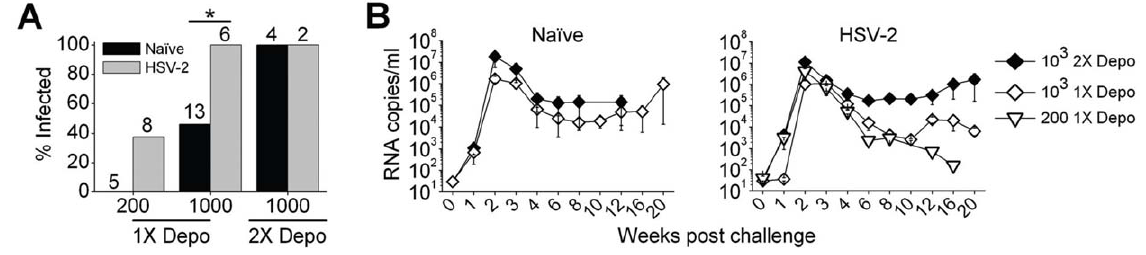
Figure 2. HSV-2-exposed macaques are more susceptible to vaginal SHIV-RT infection. (A) Naı¨ve or HSV-2-exposed macaques were challenged with the indicated TCID 50 of SHIV-RT or SHIV-RT and HSV-2 (respectively), after receiving one (1X) or two (2X) doses of Depo-Provera (Fig. S1) and the percentage of SHIV-RT-infected animals is shown (numbers above the bars indicate animal numbers per group). The asterisk marks the statistically significant (P , 0.05) difference between 1X Depo-Provera-treated naı¨ve vs HSV-2-infected animals receiving 10 3 TCID 50 of SHIV-RT. (B) Plasma viremia (mean RNA copies/ml 6 SEM) in SHIV-RT-infected naı¨ve (left panel) and HSV-2-exposed (right panel) macaques post challenge with 10 3 TCID 50 after 2 doses of Depo (10 3 2X Depo - Naı¨ve n=4; HSV-2 n=2) or after 1 dose of Depo (10 3 1X Depo - Naı¨ve n=6; HSV-2 n=6) and 200 TCID 50 after 1 dose of Depo (200 1X Depo - HSV-2